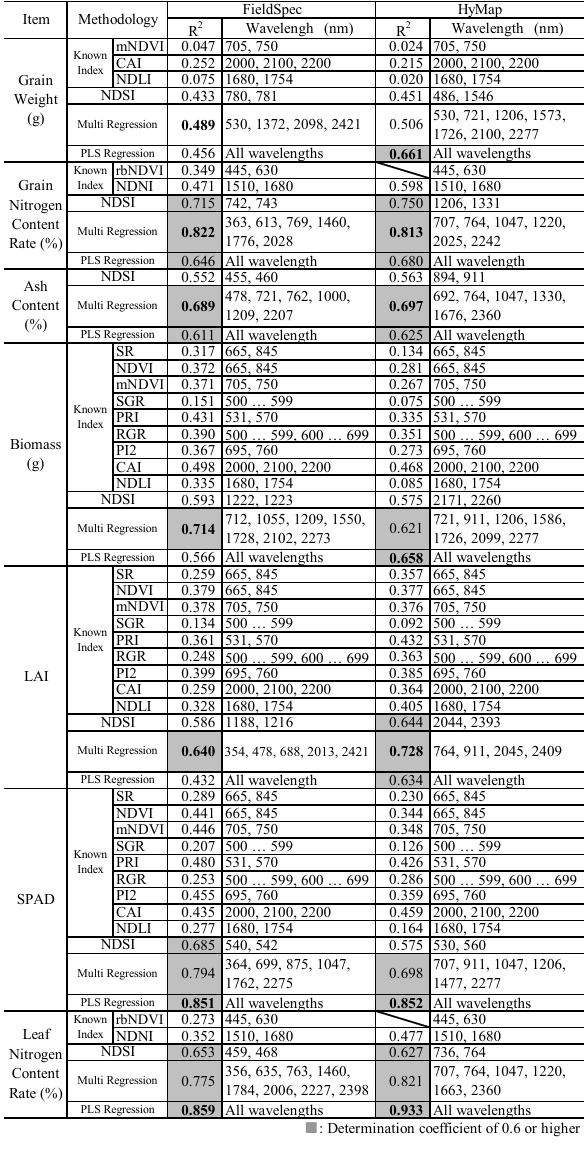
Table 5: Determination Coefficient for Heading Stage